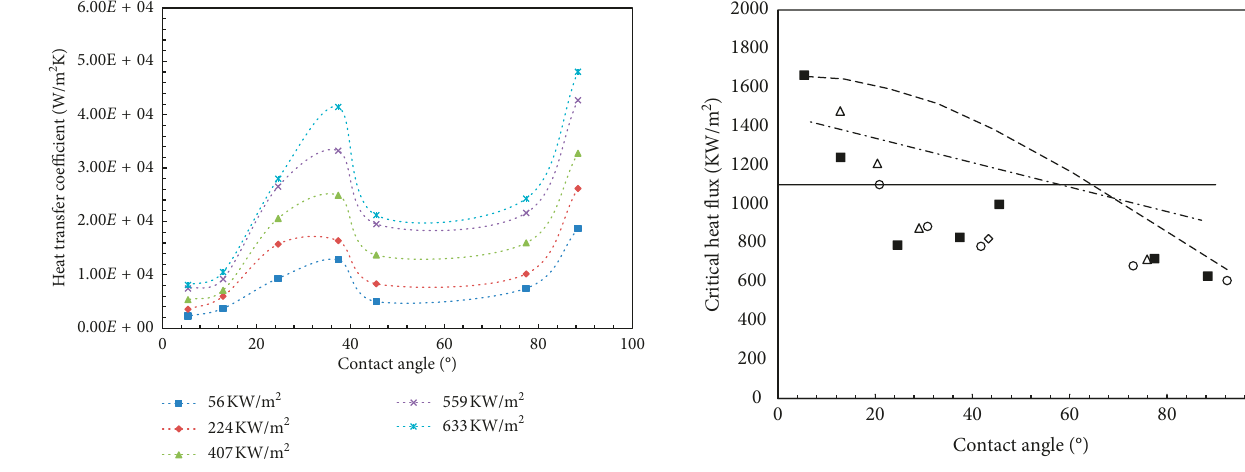
Figure 14: Heat transfer coefficient versus the contact angle.